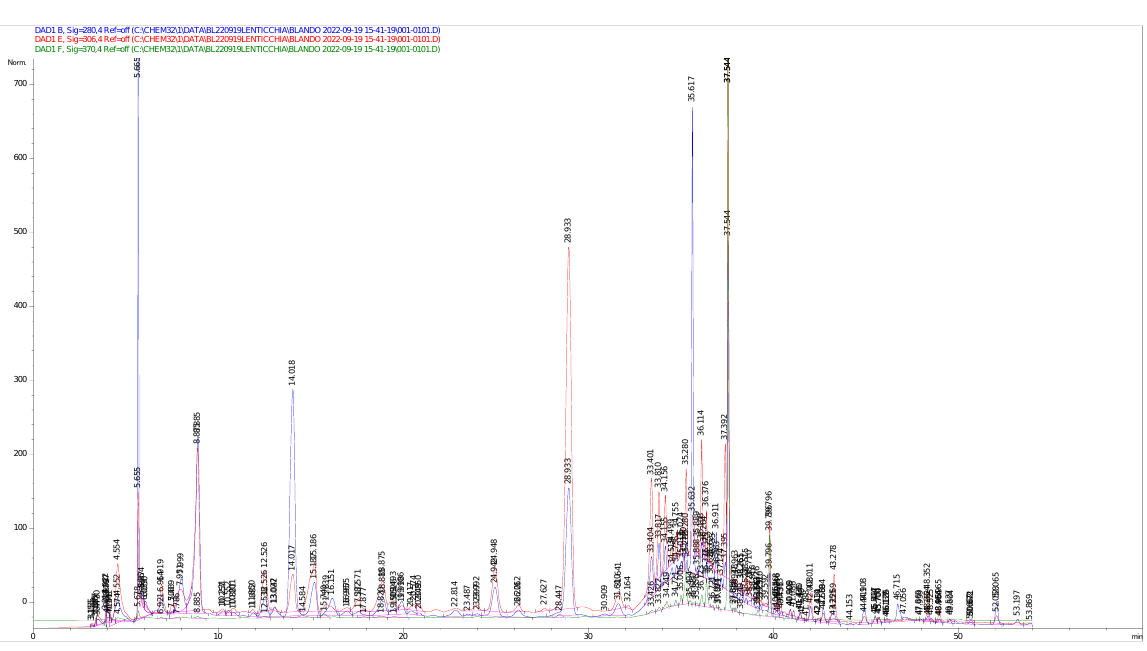
Figure A4. Representative chromatogram of tocochromanols identified on the basis of RT and ab- sorption spectra in the extracts of Svevo, Svevo HA and Faridur. αT3, βT3, αT: α - Tocotrienol, β - Tocotrienol and α -Tocopherol, respectively. Appendix F